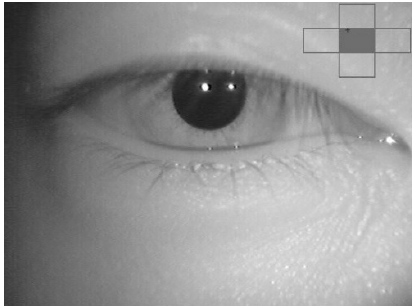
Figure 16. Sample of a video frame from Video No. 2.